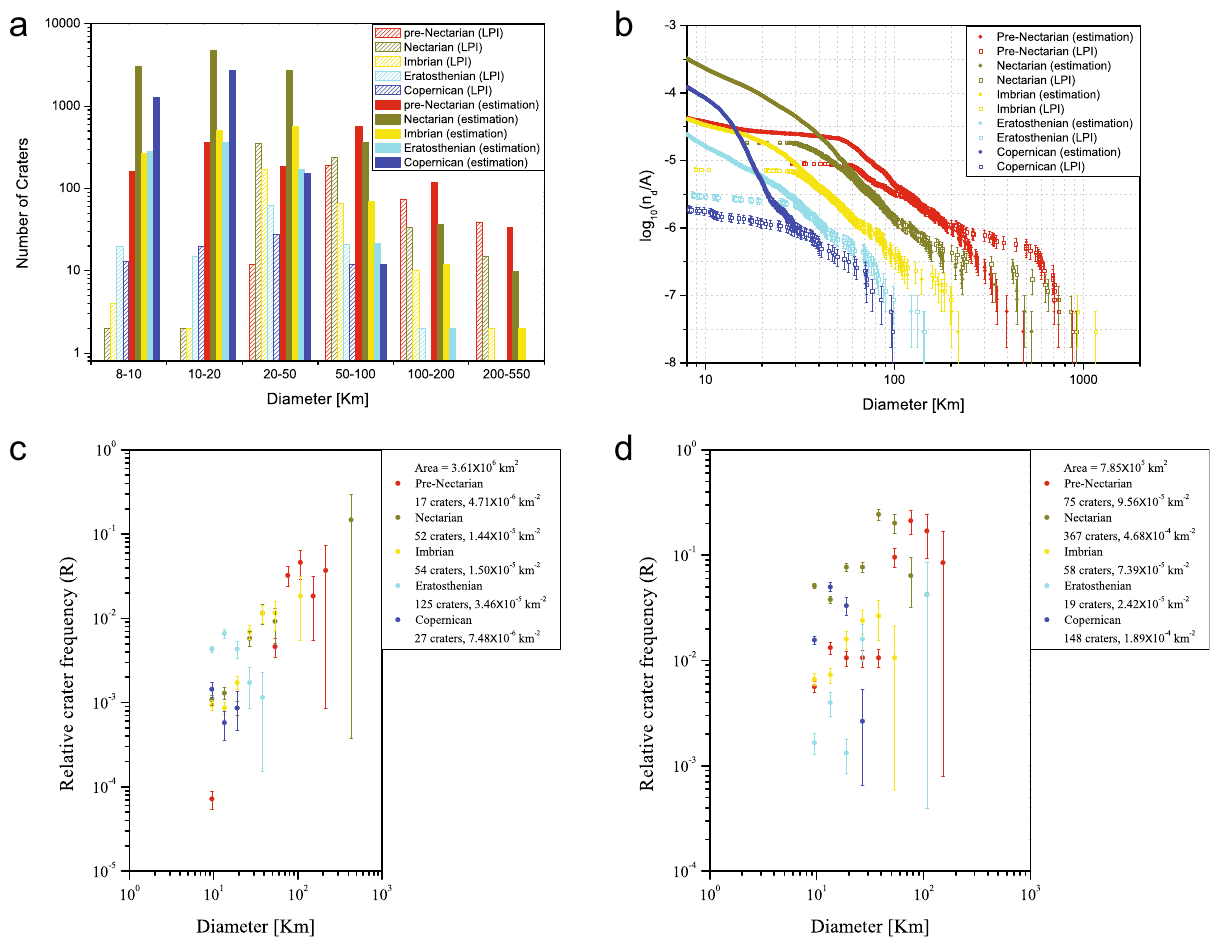
Fig. 7 Dated lunar crater size-frequency distributions. a Number of estimated craters and related assigned ages from the Lunar and Planetary Institute (LPI) with fi ve ages in different diameter scales. Source data are provided as a source data fi le. b The cumulative size-frequency distributions (CSFDs) of identi fi ed craters with estimated ages and recognized craters with ages. Source data are provided as a source data fi le. The red, brown, yellow, green and blue lines represent the estimated crater CSFDs of the pre-Nectarian System, the Nectarian System, the Imbrian System, the Eratosthenian System and the Copernican System, respectively, and the hollow lines show recognized crater CSFDs of the fi ve systems in the LPI used for age estimation. The con fi dence ffiffiffi p (cid:3) (cid:4) (cid:3) (cid:4) = A k , where A is the surface area, k th crater means that the k th-largest crater at the level of diameter. interval ± σ , which for the k th crater is log k ± Source data are provided as a source data fi le. c , d R plots (areal density) of dated craters superimposed on lunar nearside mare and farside highland areas, illustrating the difference in density and CSFD slope of the fi ve systems on the two terrains. The con fi dence interval ± σ is log R ± R = value, N is the cumulative number of craters. Source data for c , d are provided as a source data fi